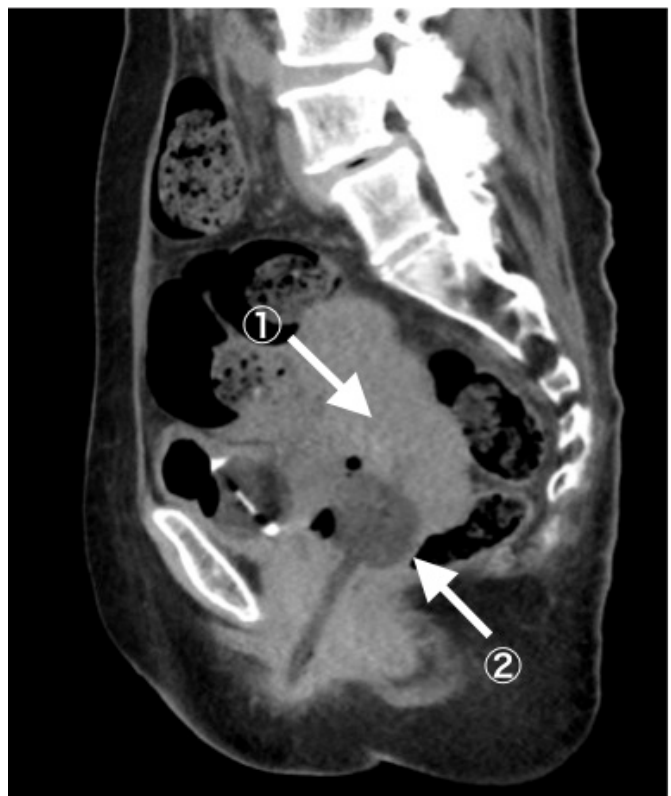
Figure. Successful balloon tamponade from the intrauterine mass using Foley catheter. Arrow 1: mass and coagulated blood filling the uterine cavity. Arrow 2: foley catheter balloon put at the uterine